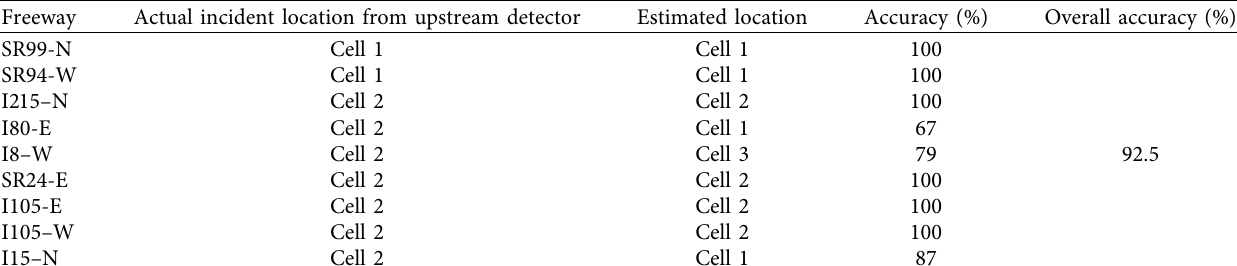
Table 7: Details of location estimation of incident.